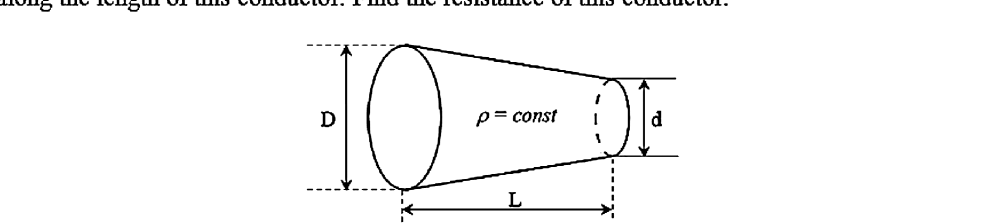
FIG. 4. The truncated-cone conductor problem (interview 6).